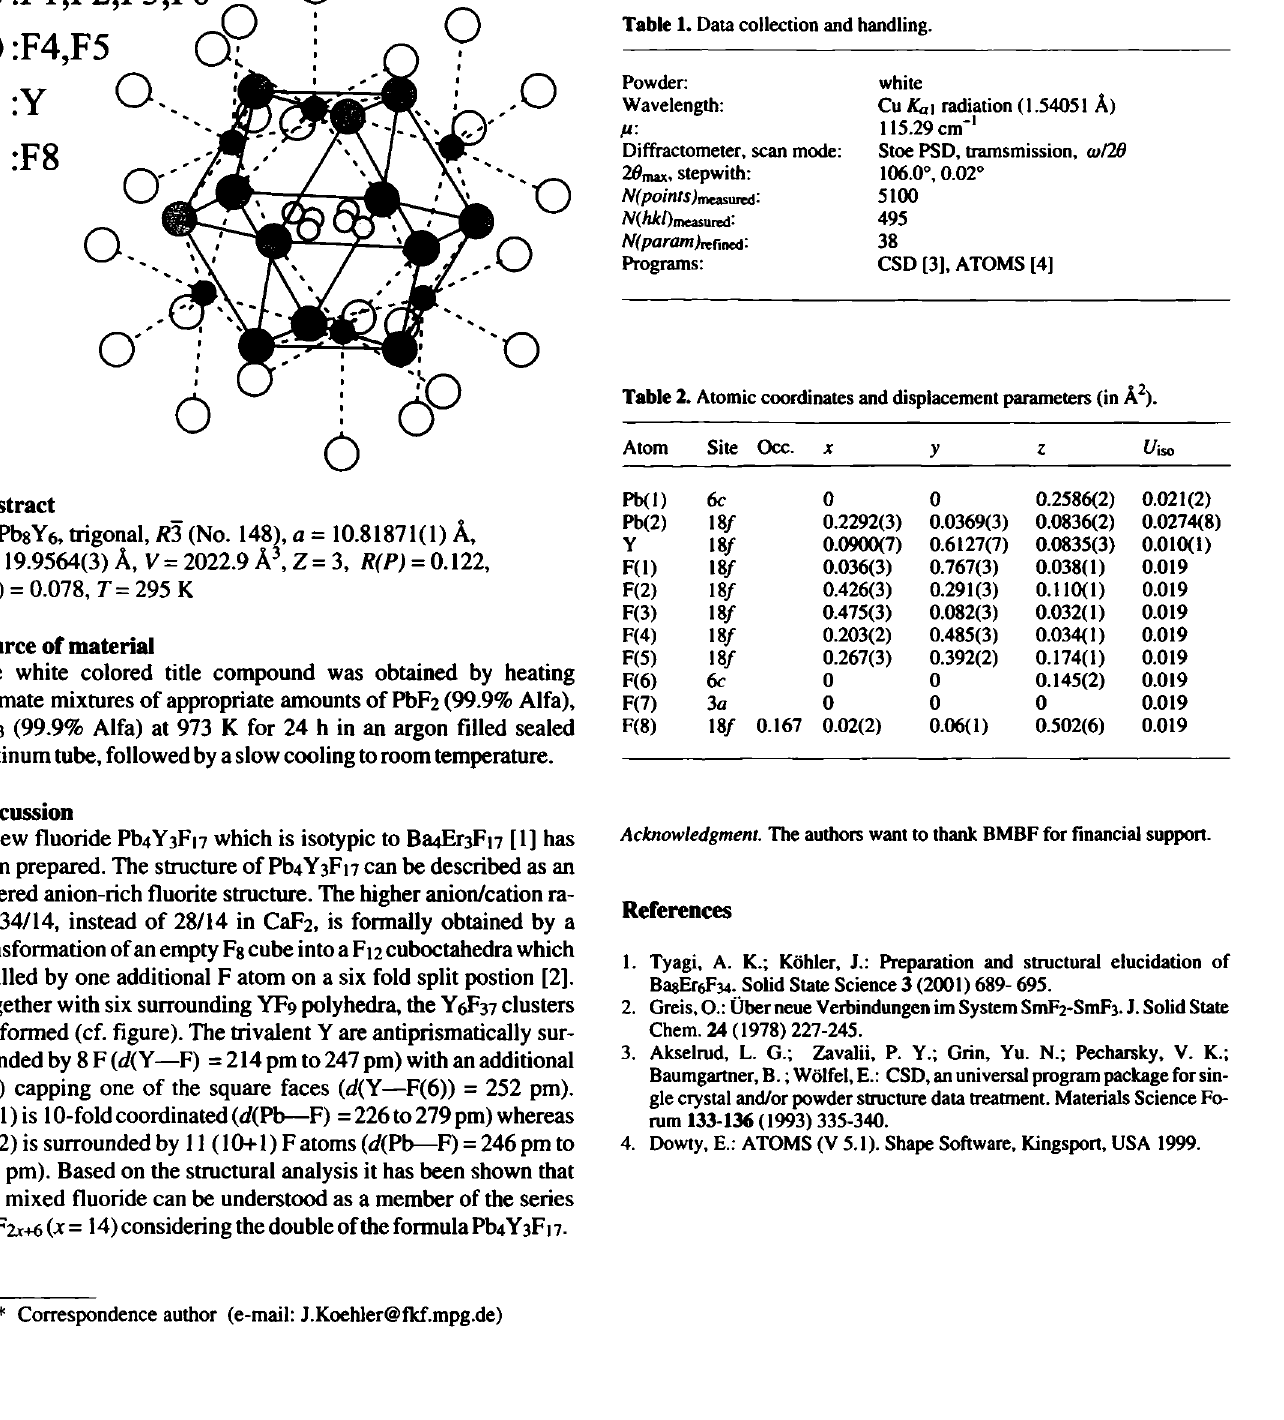
Table 1. Data collection and handling.